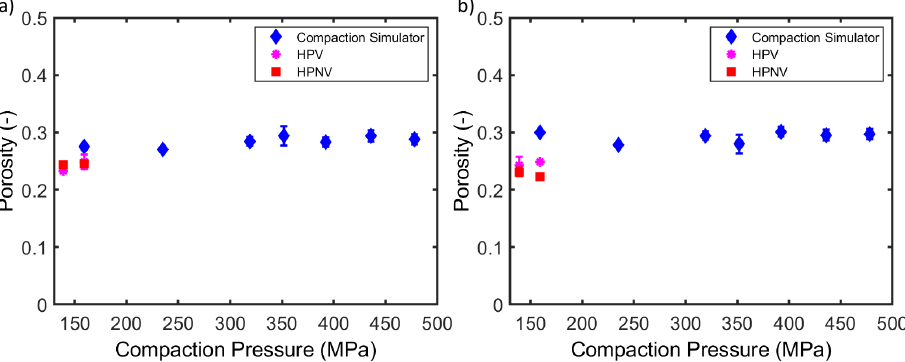
Figure 7. Sample porosity for ( a ) HDPE1 and ( b ) HDPE2 pellets compacted at 159 MPa. Three compaction methods were used: hydraulic press with a vacuum (HPV) and without a vacuum (HPNV) as well as a compaction simulator (CS). Values plotted are the mean with the error bars depicting ± one standard deviation ( n = 10).